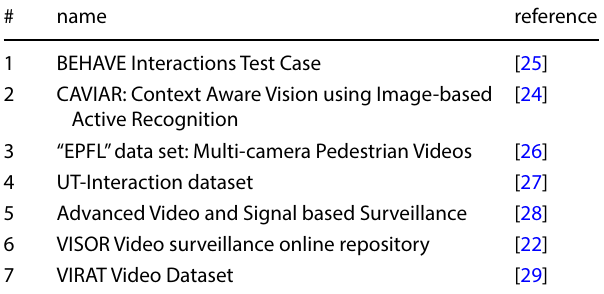
Table 5 Used parameters for the 3 classification DNNs